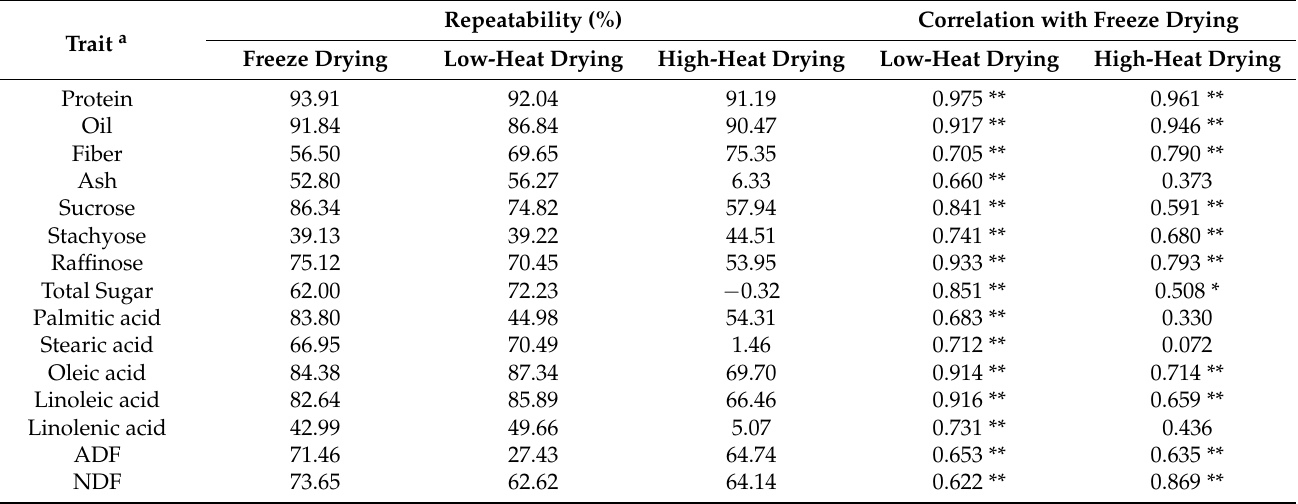
Table 7. Estimates of repeatability of edamame drying methods and correlations between heat drying and freeze drying with ground